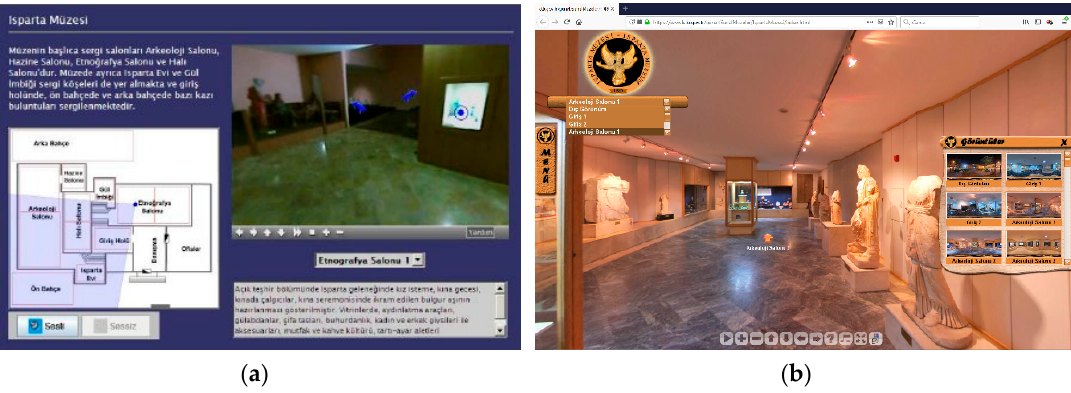
Figure 3. Isparta Museum Virtual Tour. ( a ) The interface shows a floor plan window on the left and a viewing window on the right; pull-down menu described in [13] seems absent; ( b ) the new interface version available nowadays [14] seems not to adopt usability assessment suggestions; moreover, the floor plan and the hotspots on the artifacts have been